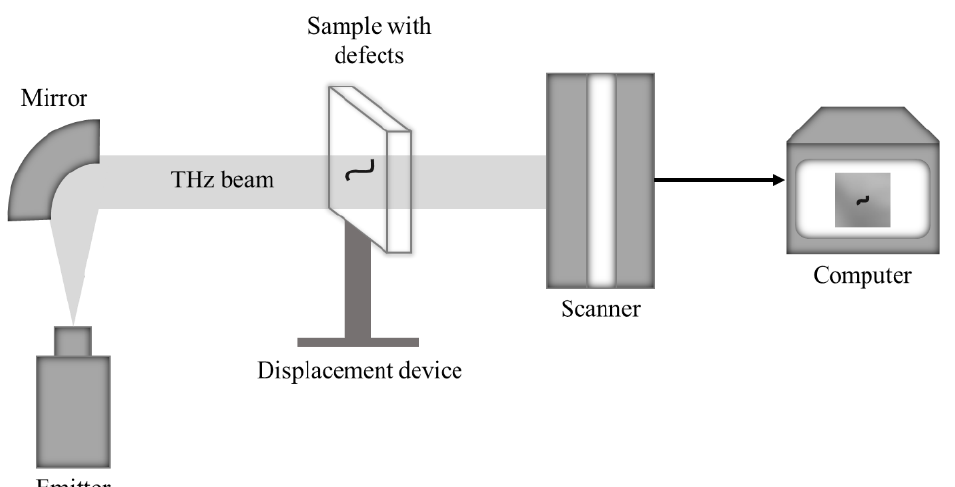
Figure 11. Schematic representation of experimental setup operated via Terahertz method in trans- mission mode [28].